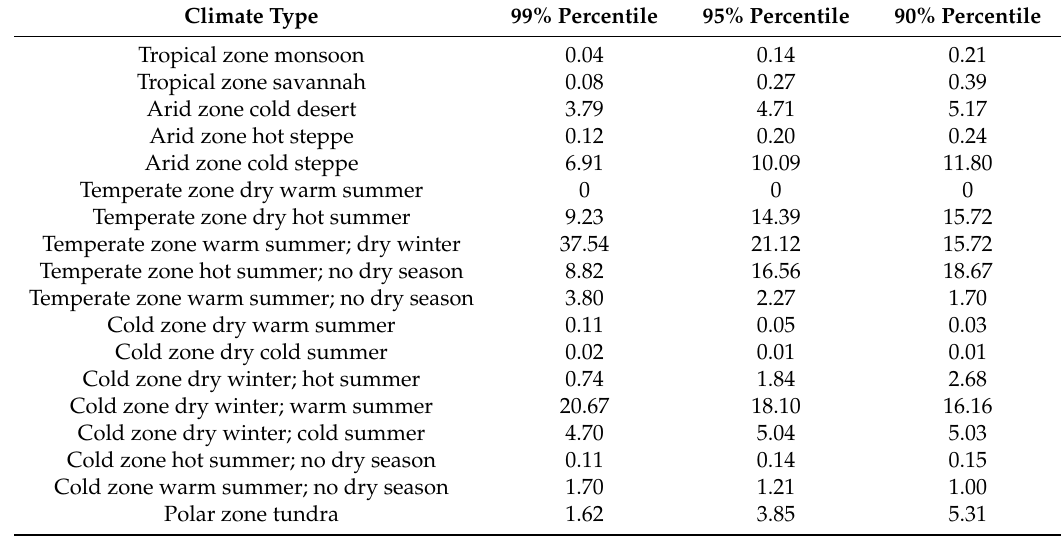
Table 9. Pixel proportion of different climate types at three relative standard deviation percentile